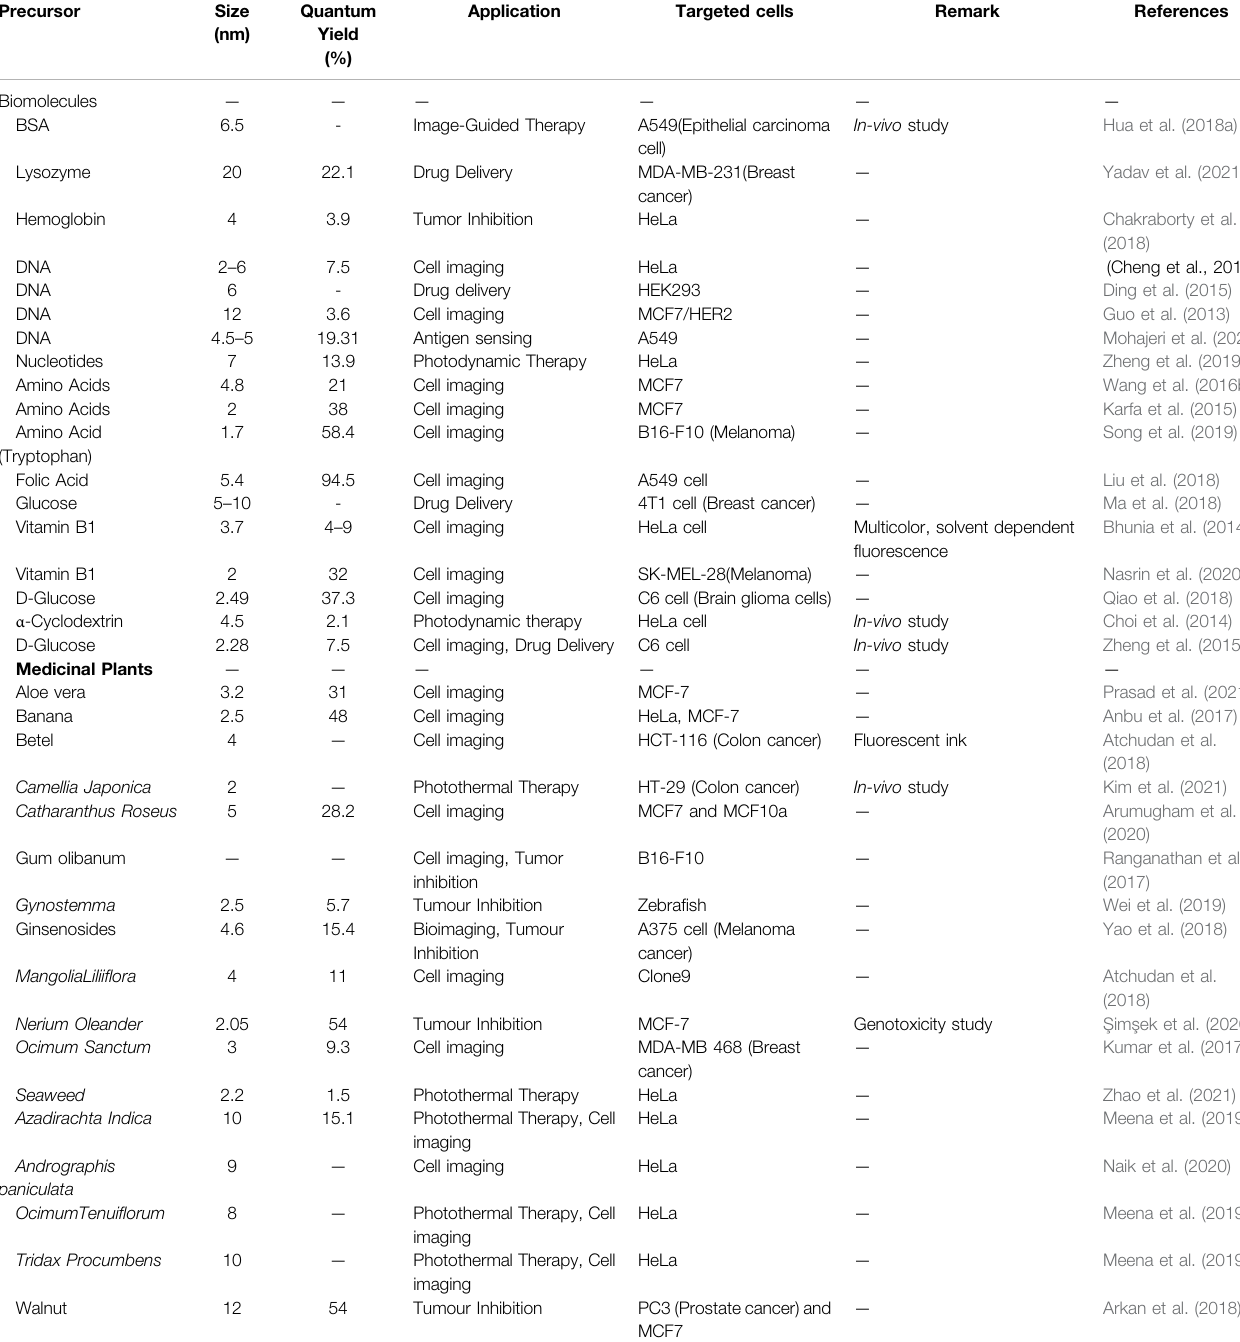
TABLE 2 | Properties, precursors and applications of biomolecules and medicinal plants derived